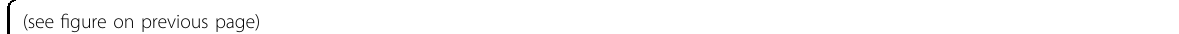
Fig. 1 Inhibition of EZH2 promotes the cholesterol synthesis pathway. A IC 50 of three EZH2 inhibitors in different HNSCC cell lines. B KEGG enrichment of RNA-Seq data to analyse the signi fi cantly 2-fold changed genes in the CAL27 cell line treated with the EPZ6438 compared to the vehicle. C The most changed genes in the cholesterol synthesis pathway. D GSEA was performed to analyse the expression pattern. E Multiple changes in the endogenous enzyme cholesterol synthesis pathway after HNSCC cells were treated with EPZ6438. F Real-time PCR assays to detect the EPZ6438-induced expression of cholesterol synthesis enzymes in various HNSCC cell lines. N = 3 replicates. E10 (EPZ6438-10 μ M), E20 (EPZ6438- 20 μ M). G Real-time PCR assays to detect the GSK126-induced expression of cholesterol synthesis enzymes in various HNSCC cell lines. N =